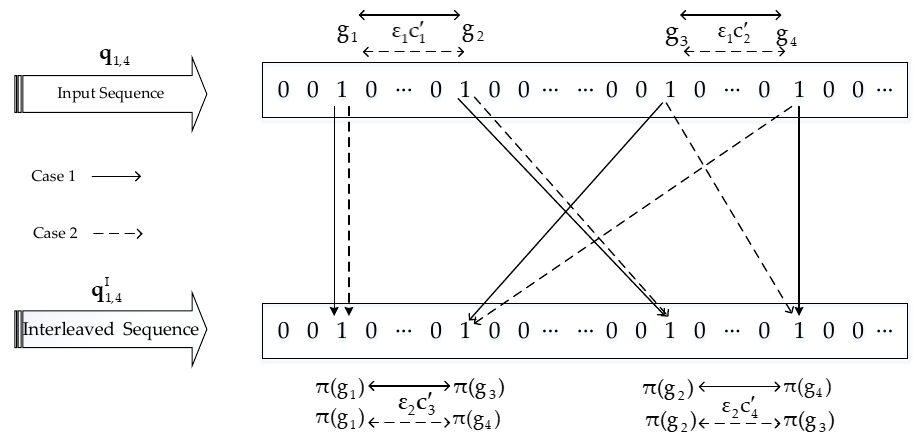
Figure 3. A weight-4 input sequence is mapped to another weight-4 input sequence after passing through the interleaver.